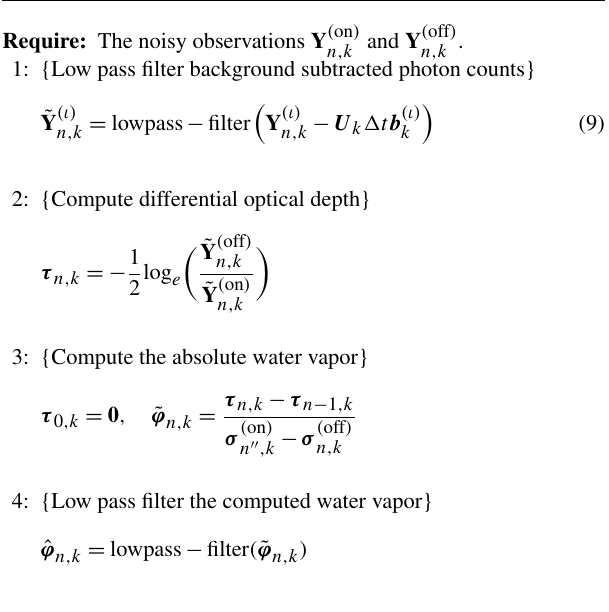
Algorithm 1 The MPD standard